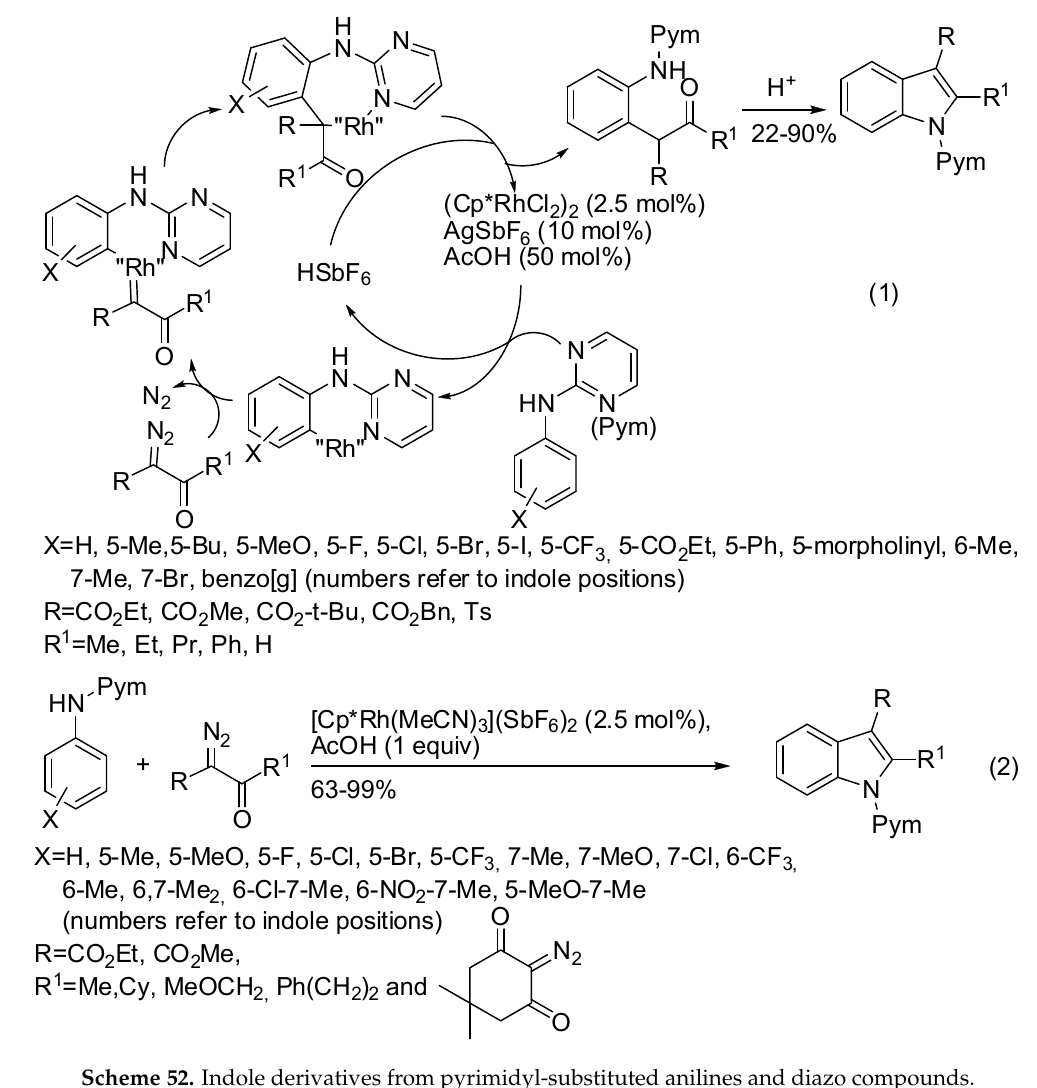
2-anilinopyridine and sulfonyl diazoesters led to the formation of oxindole derivatives (Scheme 53) [98]. Catalysts 2018 , 8 , x FOR PEER REVIEW